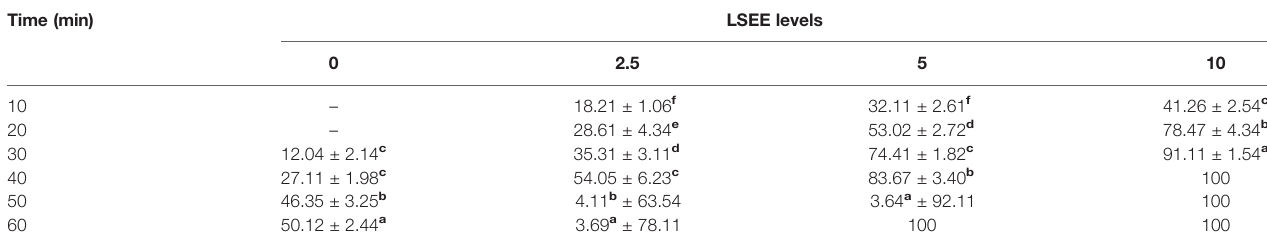
TABLE 8 | Anti-parasitic ef fi cacy of different concentrations of L. siceraria ethanolic extract on time after treatment (min) to death of C. tilapiae (%). Time